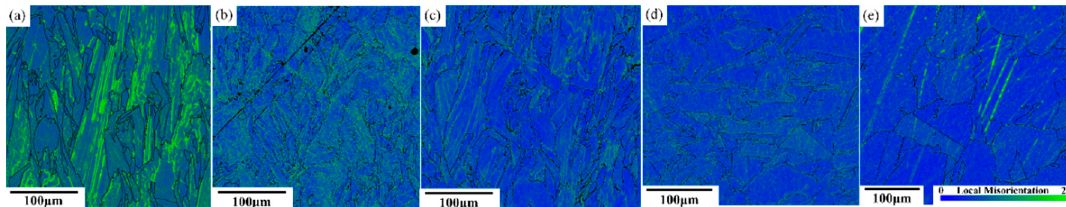
Figure 6. KAM maps of ( a ) as-built, ( b ) STA-1045 °C, ( c ) STA-1065 °C, ( d ) STA-1120 °C, and ( e ) STA-1180 °C/1 h specimens were analyzed using the orientation measurements by EBSD. A square scanning grid and neighbor shell (5 × 5) were used to calculate the misorientation. These KAM maps were run at a 0.5 μ m step size using a 600 × 600 point grid.